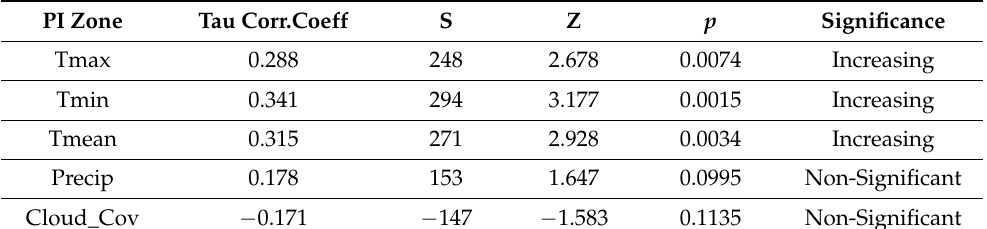
Table 11. Mann Kendall Trend Test of JJAS averaged climatic variable for PI zone.